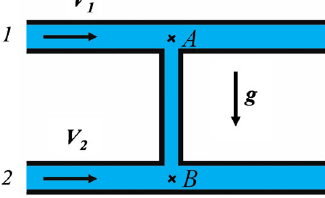
FIG. 4. A fluid is flowing with different velocities in two horizontal pipes joined by an another vertical pipe.